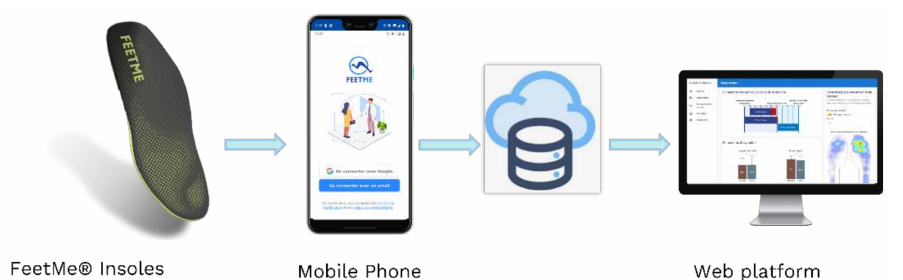
Figure A1. FeetMe ® Monitor solution includes the insoles, and the mobile application to collect data and to transfer to the web platform. The web platform shows the gait parameters and the pressure